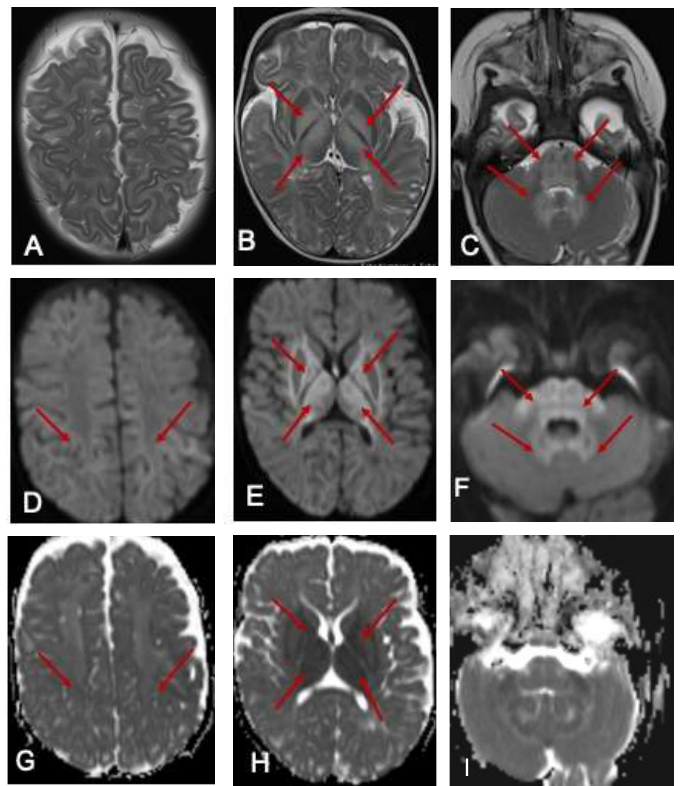
Figure 1. MRI of the brain at 7 months. The red arrows show the hyperintense signal changes. T2-weighted axial images of an MRI scan of the brain at 7 months of age ( A – C ) show hyperin-tense signal changes in the white matter ( A ), globus pallidus ( B ), and thalamus ( B ); pons, cere-bellar peduncle, and dentate nucleus ( C arrows). The corresponding areas show restricted diffu-sion in DWI Images ( D – F ) and ADC maps ( G – I